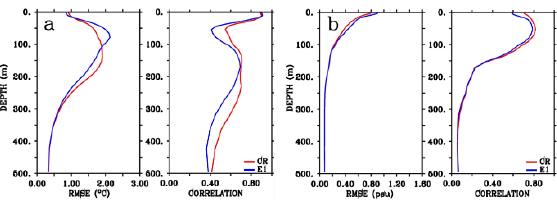
Figure 5. Vertical RMSE profile of simulated model